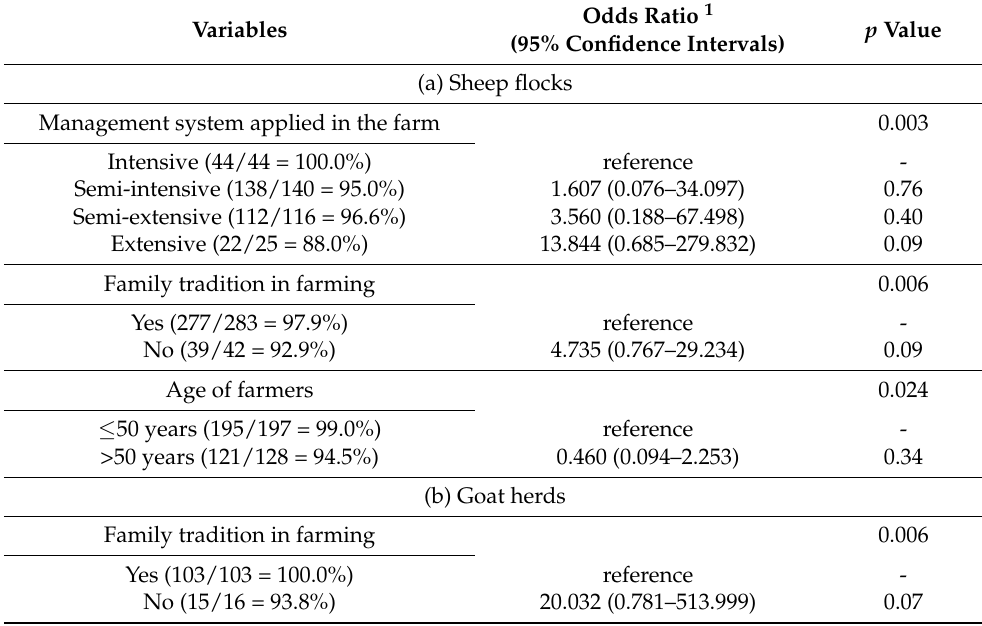
Table A2. Multivariable analysis for variables associated with optional vaccination against clostridial infections in 444 small ruminant farms in Greece.